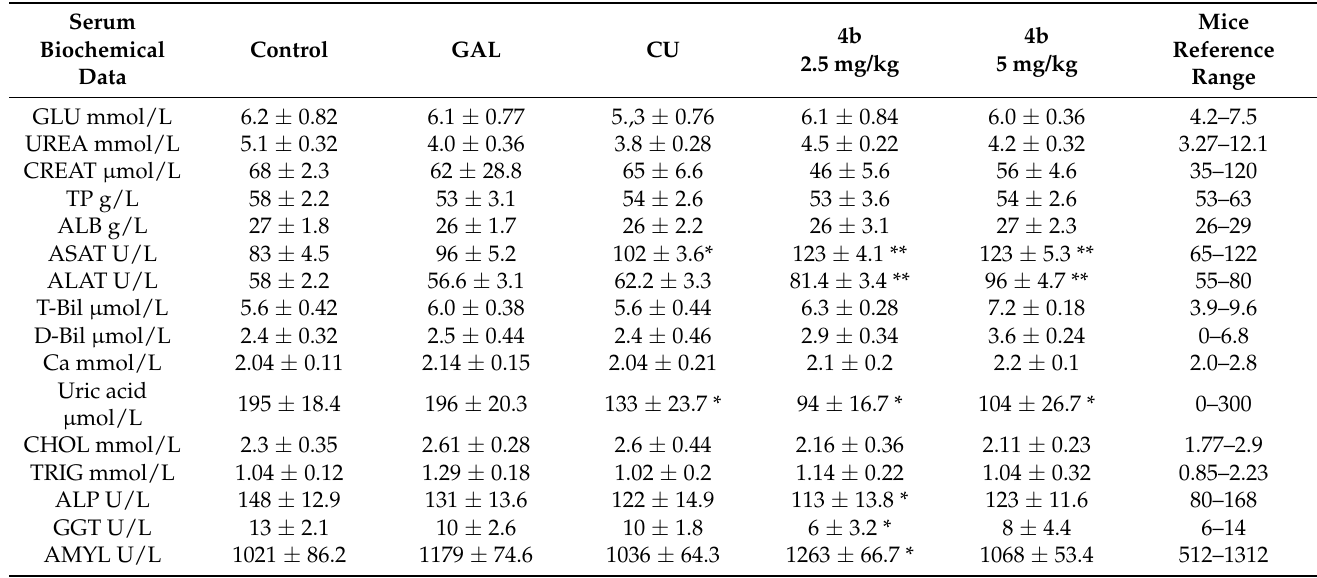
Table 2. Serum biochemical data after 14 days of treatment by GAL, CU, two doses of 4b or placebo. Values are means ± standard deviation ( n = 6). Mice reference ranges are given according to Refs. [38,39] and the reference val- ues of our laboratory.